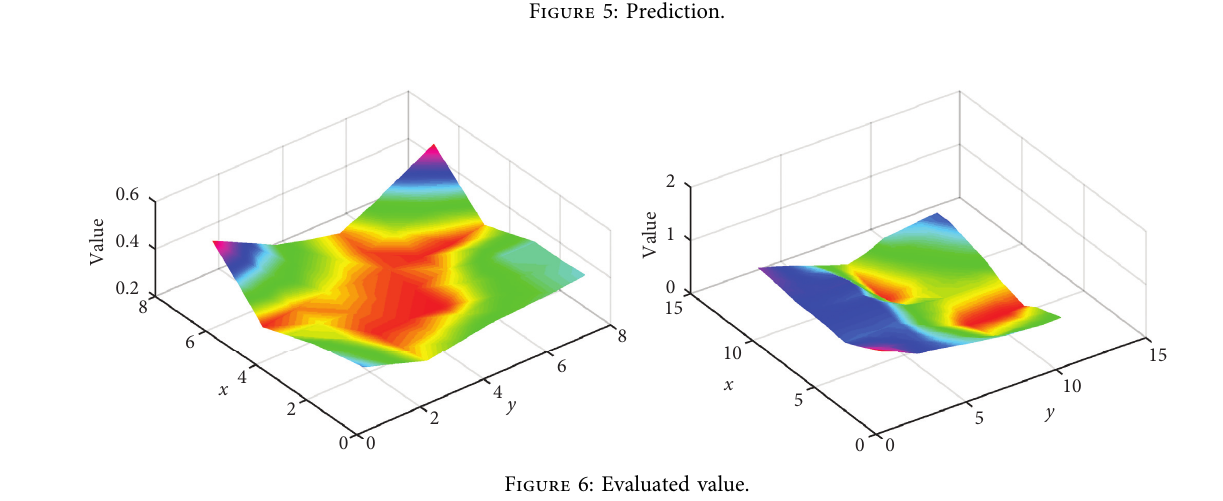
Figure 6: Evaluated